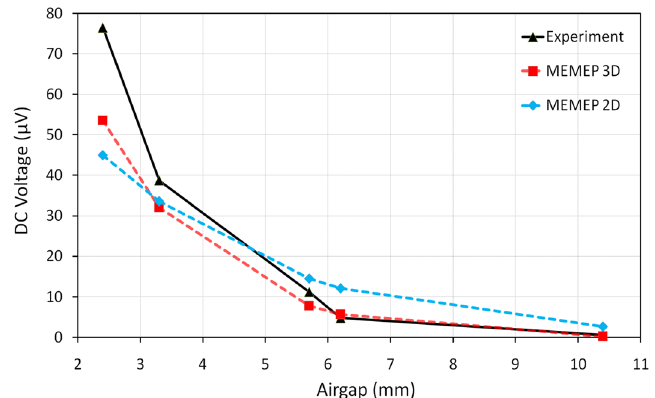
Figure 8. Comparison between DC open-circuit voltage values of different airgaps for calculated results of MEMEP 3D modeling against MEMEP 2D modeling presented in 7 and experiments conducted in 34 . Better agreement for 3D modeling is evident at large airgaps, while for low airgaps we expect significant measurement